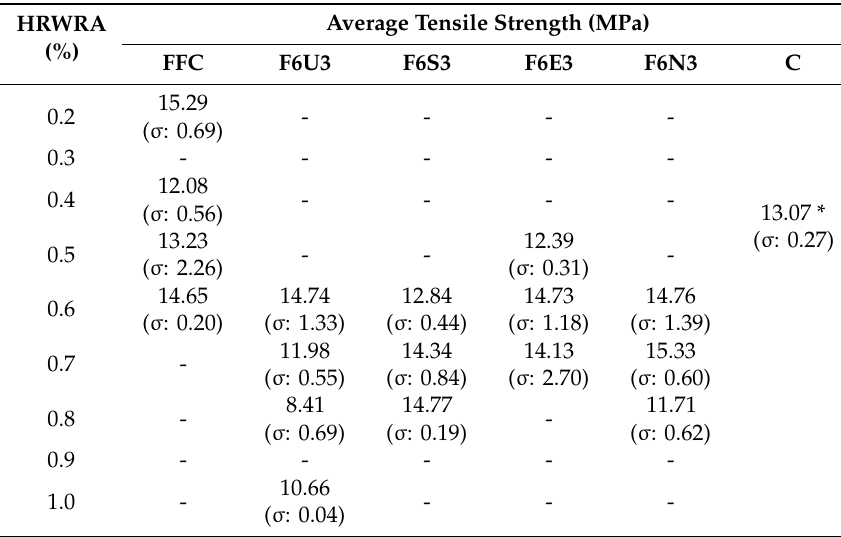
Table 6. Average 28-days tensile strength ( σ = standard